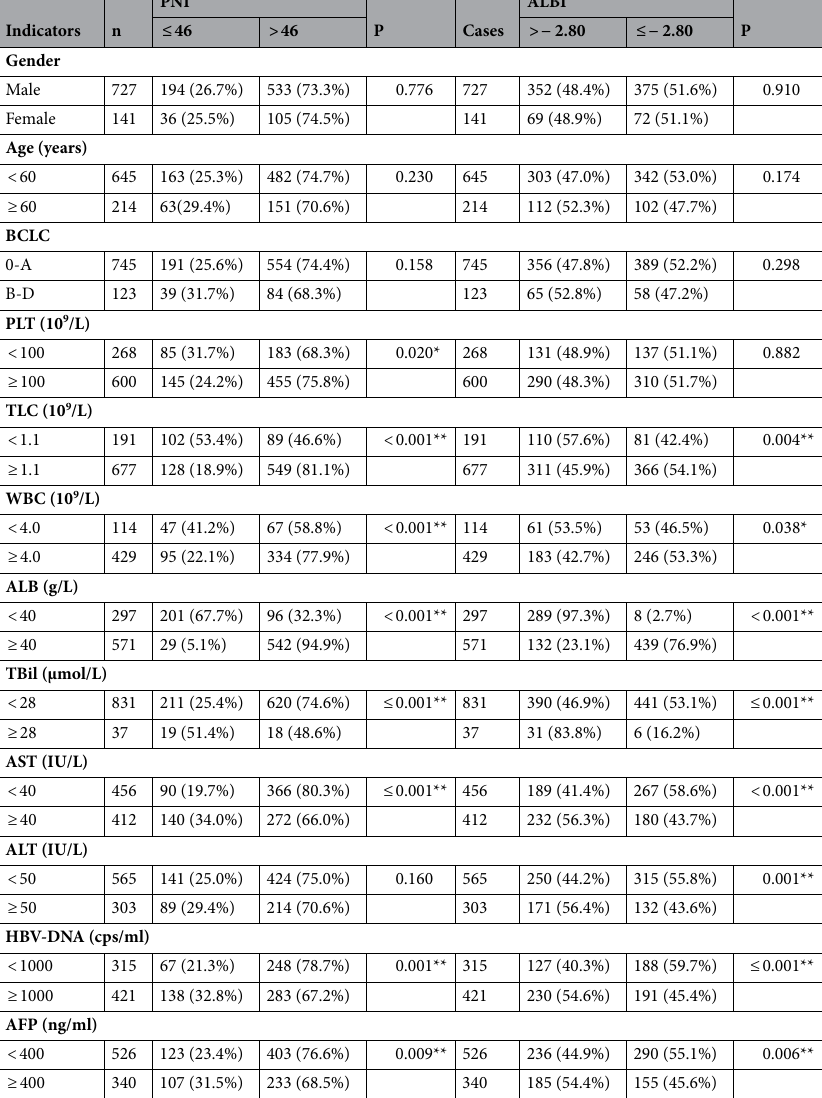
Table 1. The correlation analysis between PNI, ALBI and the general condition, hematological qualitative indicators. *The correlation was significant in 0.05 layer (two tailed), similarly hereinafter. **The correlation was significant in 0.01 layer (two tailed), similarly